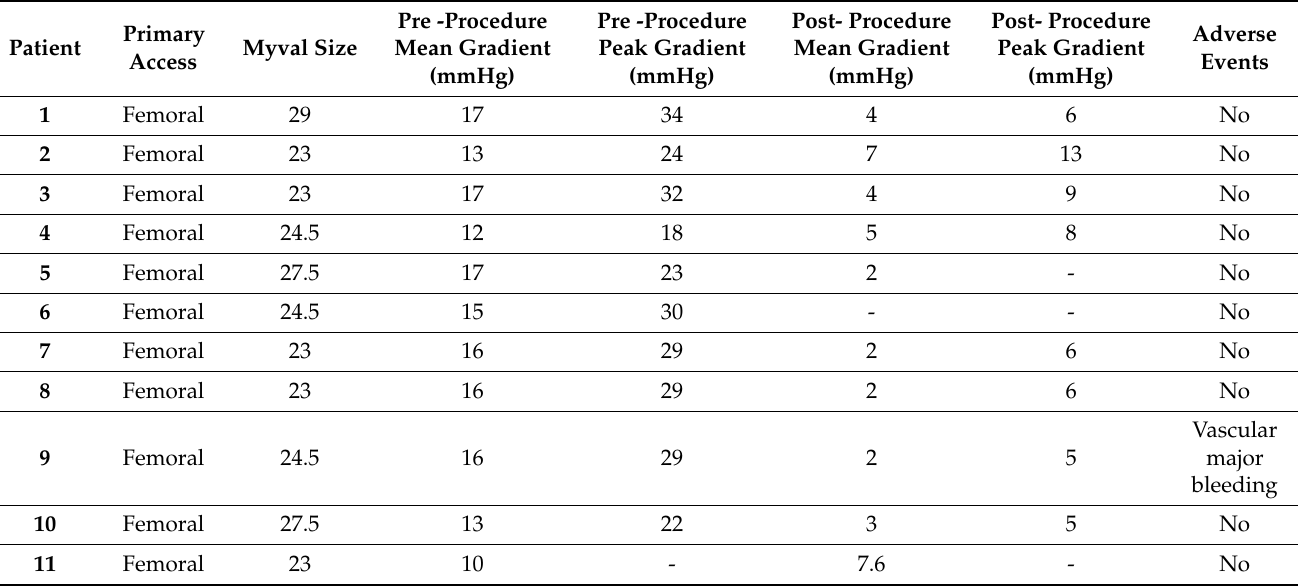
Table 2. Procedural aspects, and pre- and postprocedural echocardiographic